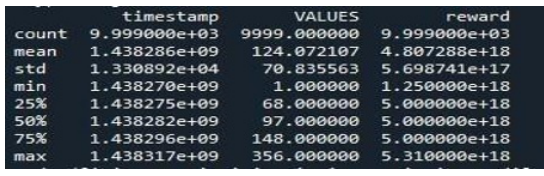
Fig 2. with the distribution of the data frame columns,